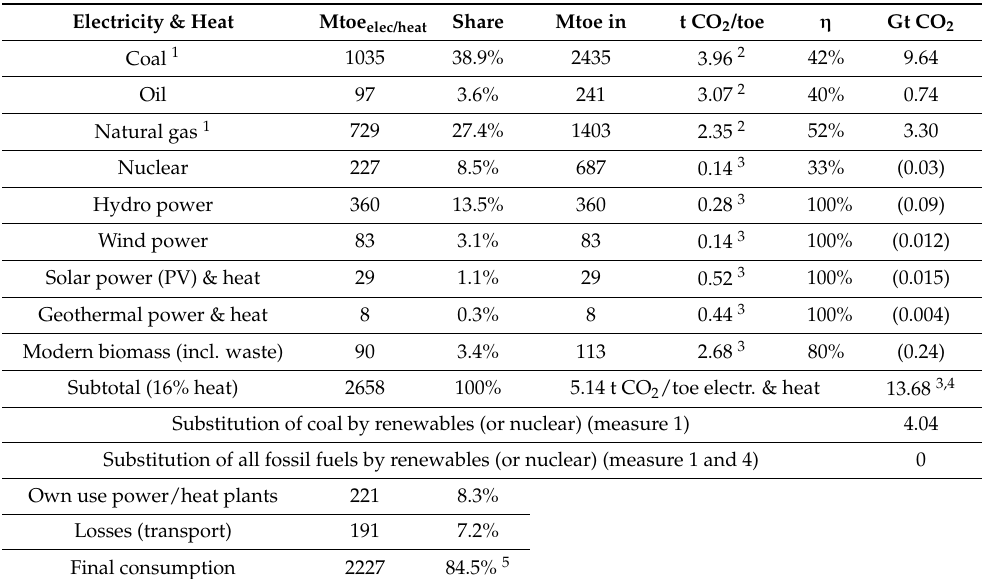
Table 4. Global electricity & heat 2016 (incl. CHP, direct heat, autoproducers) 2016 (data from [8]; shares within renewables from [19]). Efficiency η is the ratio of output of electricity & heat to fuel input on the basis of